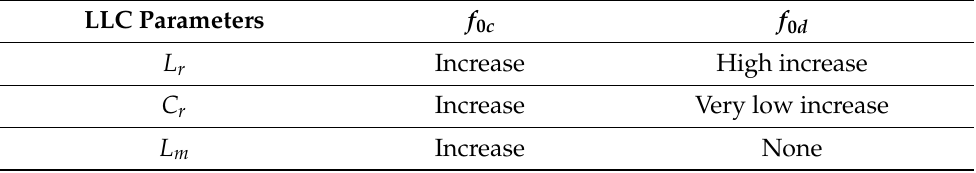
Table 1. Effect of LLC parameters decrease on feedforward switching